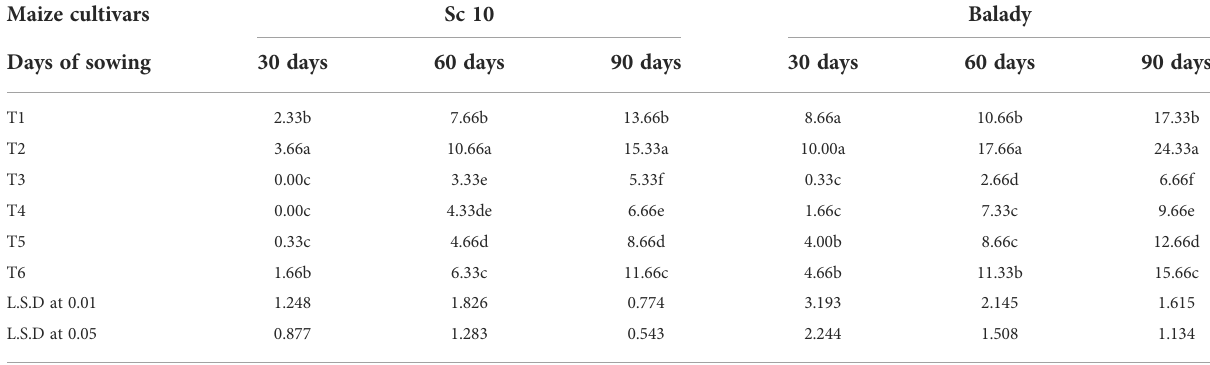
TABLE 7 Fusarium verticillioides frequency % from stalk under different soil treatments at different times after sowing during the 2021 growing season. Maize cultivars Sc 10 Balady Days of sowing